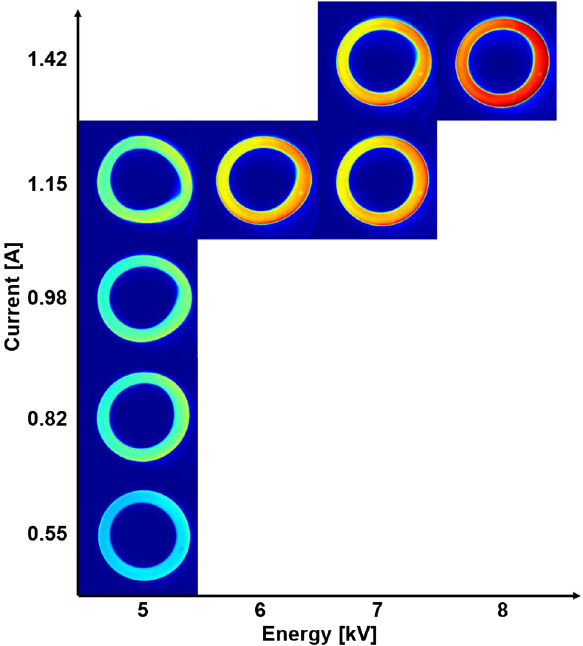
FIG. 4. Measured hollow beam profiles with different electron beam currents and energy. The color scale represents the relative intensity of the pixels with arbitrary units.